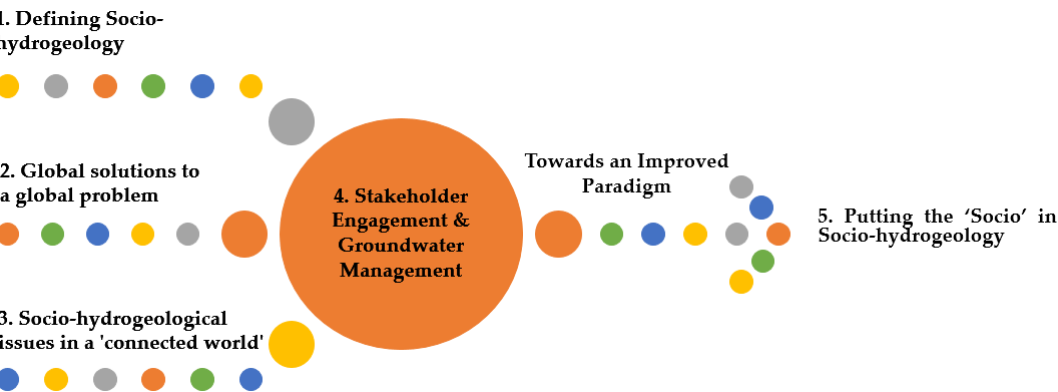
Figure 1. Overview of paper structure: We present the evolution of the definition of socio- hydrogeology, its importance in a global context, as well as challenges and solutions for socio-hydrogeology. We highlight the importance of stakeholder network analysis, culminating in a move towards a new paradigm that puts the socio in socio-hydrogeology.